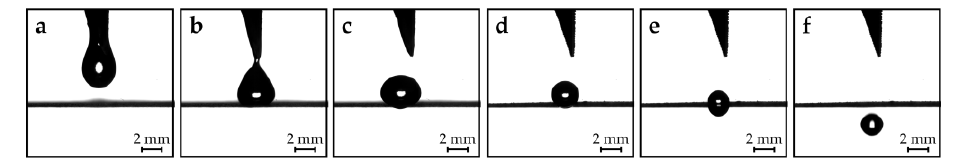
Figure 2. Operational principle. ( a ) and ( b ): Dispensing of one droplet onto the superhydrophobic hole plate. ( c ) and ( d ): Evaporation of the droplet. ( e ) and ( f ): A sufficiently small droplet passes through the hole. Figure 3 from [4] by Tröls et al., used under CC BY/Individual parts rearranged.